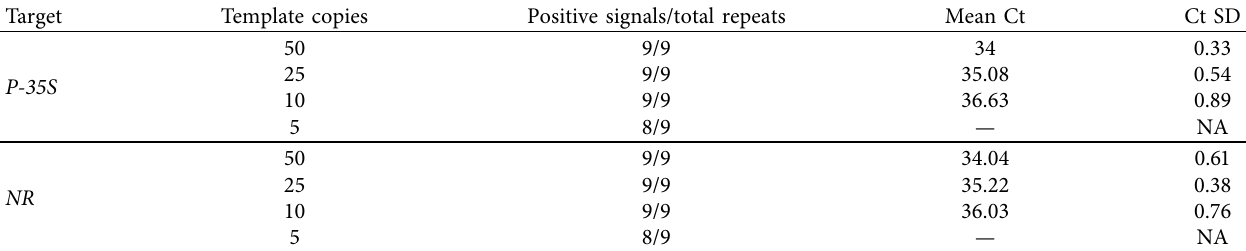
Table 3: The LOD and LOQ of the pGMT27 plasmid as the calibrator in qPCR.